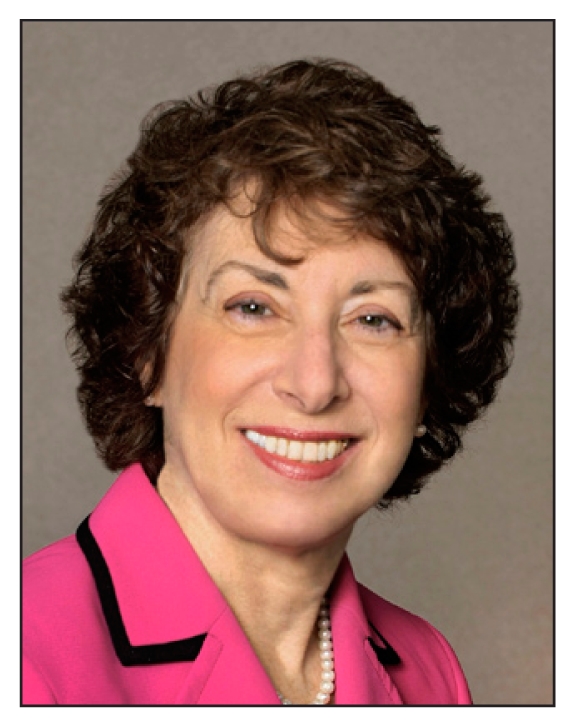
Linda S. Birnbaum